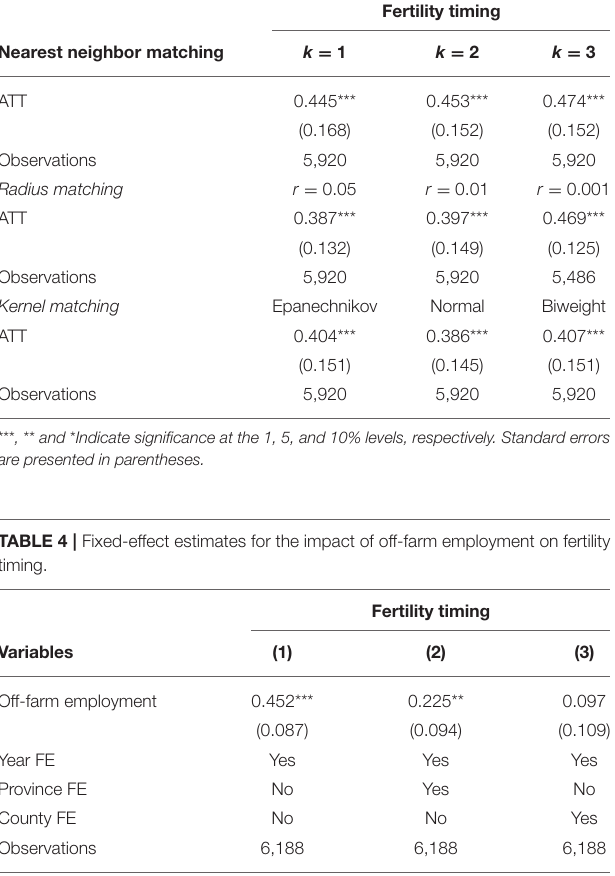
TABLE 2 | Estimates for the association between off-farm employment and fertility timing.